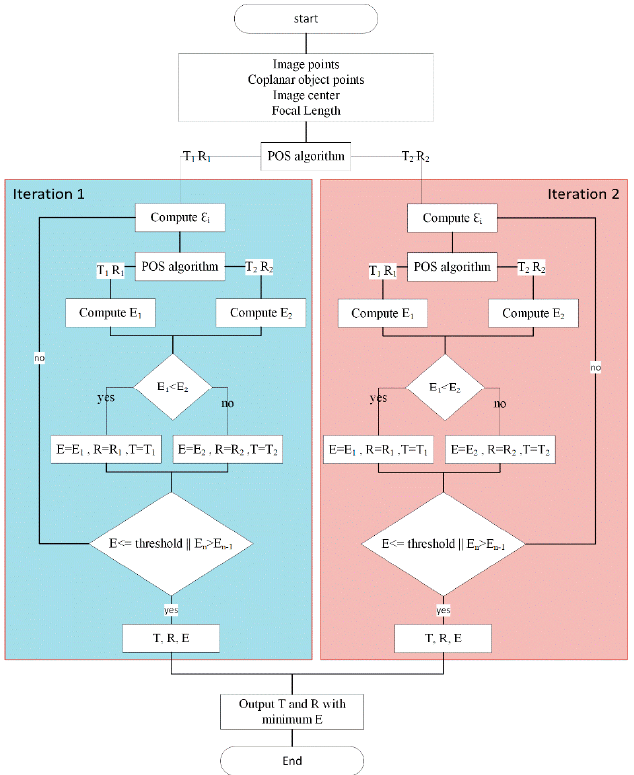
Figure 9. Coplanar POSIT flowchart.